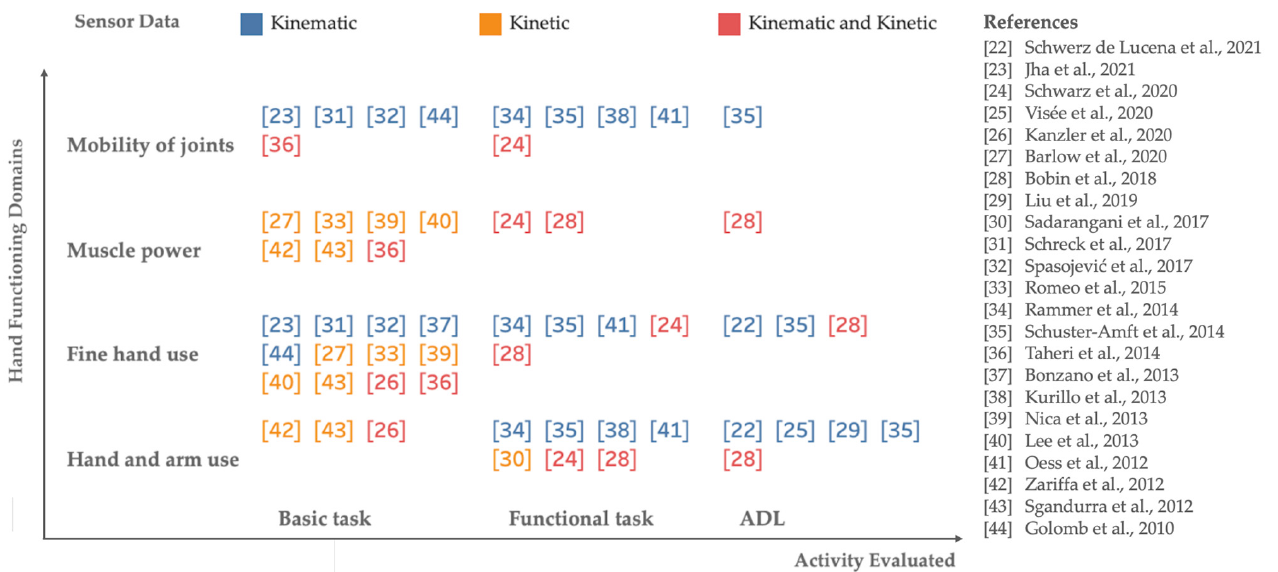
Table 3. Classification based on target population. CIDP = chronic inflammatory demyelinating